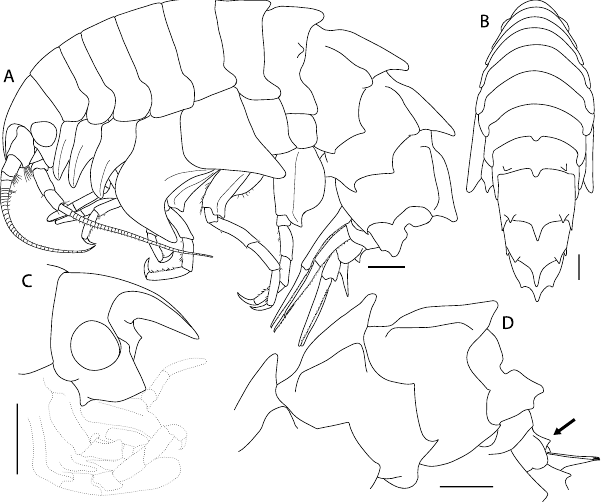
Figure 8. Epimeria frankei sp. nov., holotype, adult female, northern North Sea, NHMUK 2015.3264: ( A ) lateral habitus, ( B ) dorsal habitus, ( C ) head in lateral view, ( D ) pleon and urosome; all scales 1